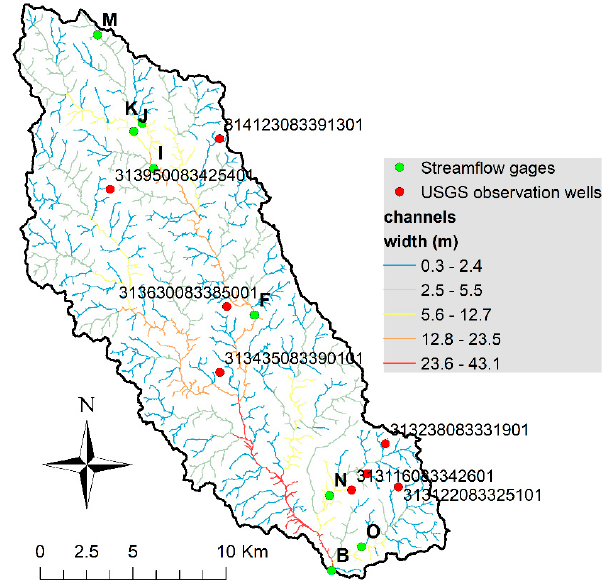
Figure 6. Map of the Little River Experimental Watershed (LREW) showing the location of the streamflow gages (B, O, N, F, I, J, K, M) and the U.S. Geological Survey (USGS) observation wells. The SWAT+ delineated channels also are shown, using color to indicate approximate channel width.